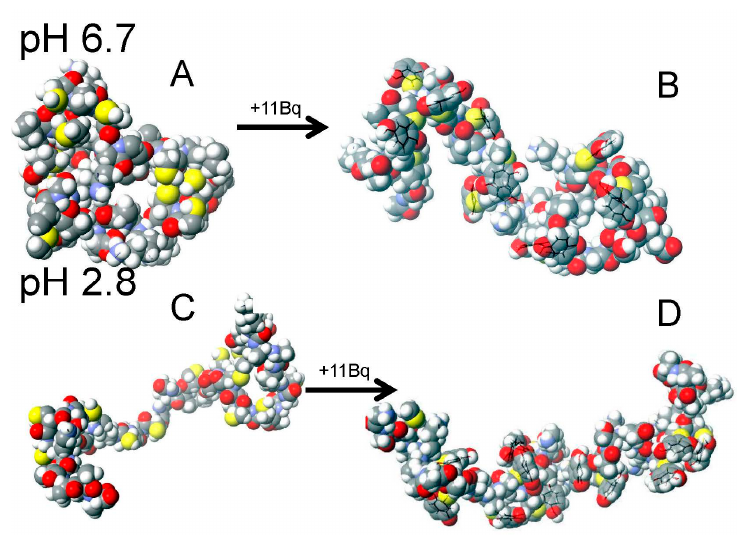
Figure 7. Molecular mechanics, molecular dynamics (MM/MD) simulation of energy minimized α -MT conformations under native ( A , B ) and denaturing ( C , D ) conditions. Apo- α MT is shown in A and C and fully modified Bq 11 - α -MT in B and D . Adapted with permission from Irvine et al., 2015 [111].